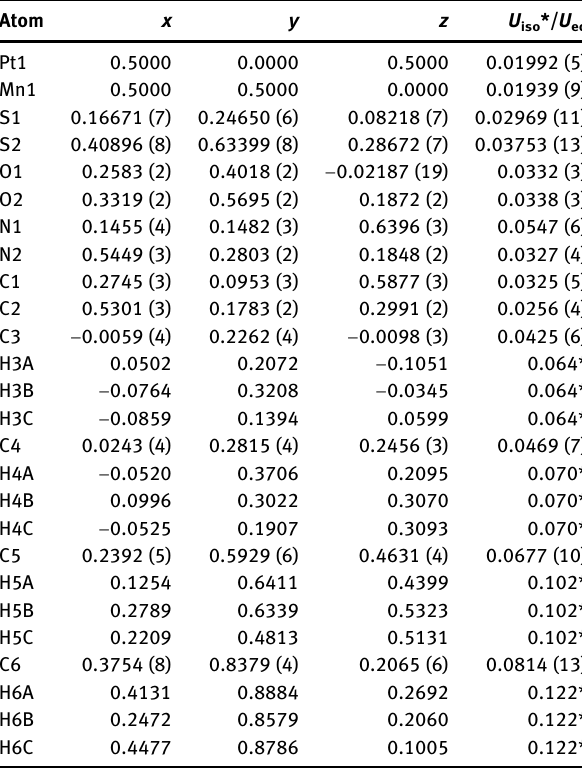
Table  : Fractional atomic coordinates and isotropic or equivalent isotropic displacement parameters (Å 